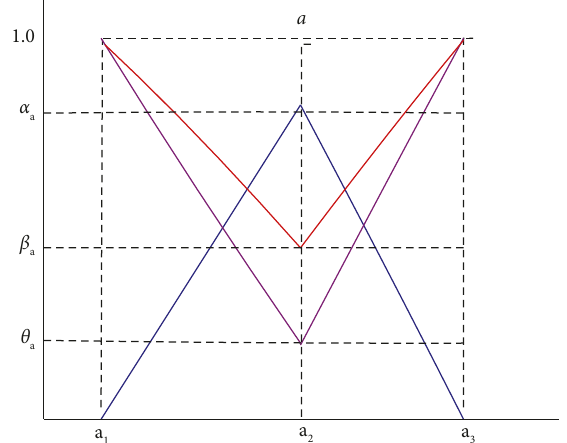
Figure 1: Single-valued triangular neutrosophic fuzzy number “a”.